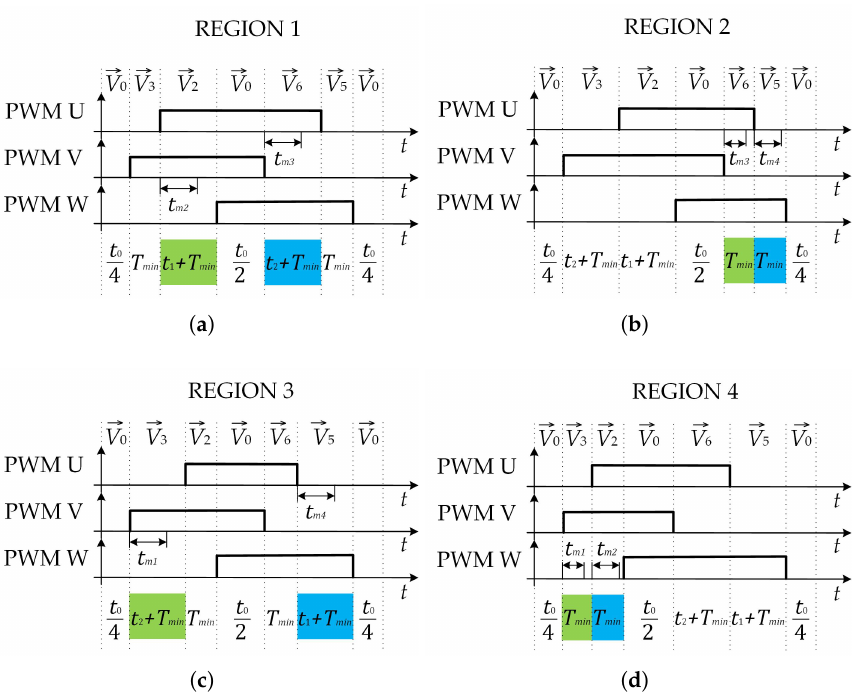
Figure 7. Proposed SVM pattern for low modulation index values: ( a ) Region 1; ( b ) Region 2; ( c ) Region 3; ( d ) Region